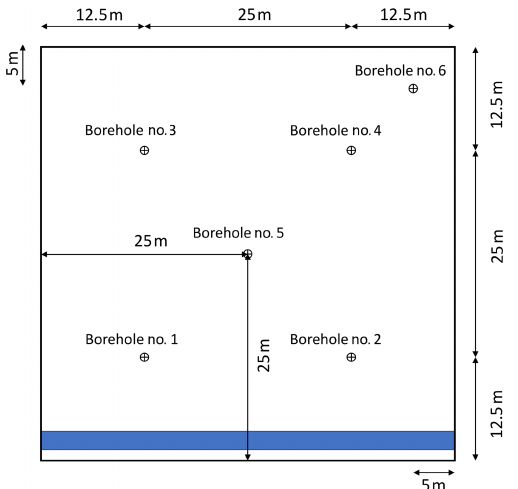
Figure 3. Observation (1–4) and validation (5 and 6) locations. The creek is plotted in